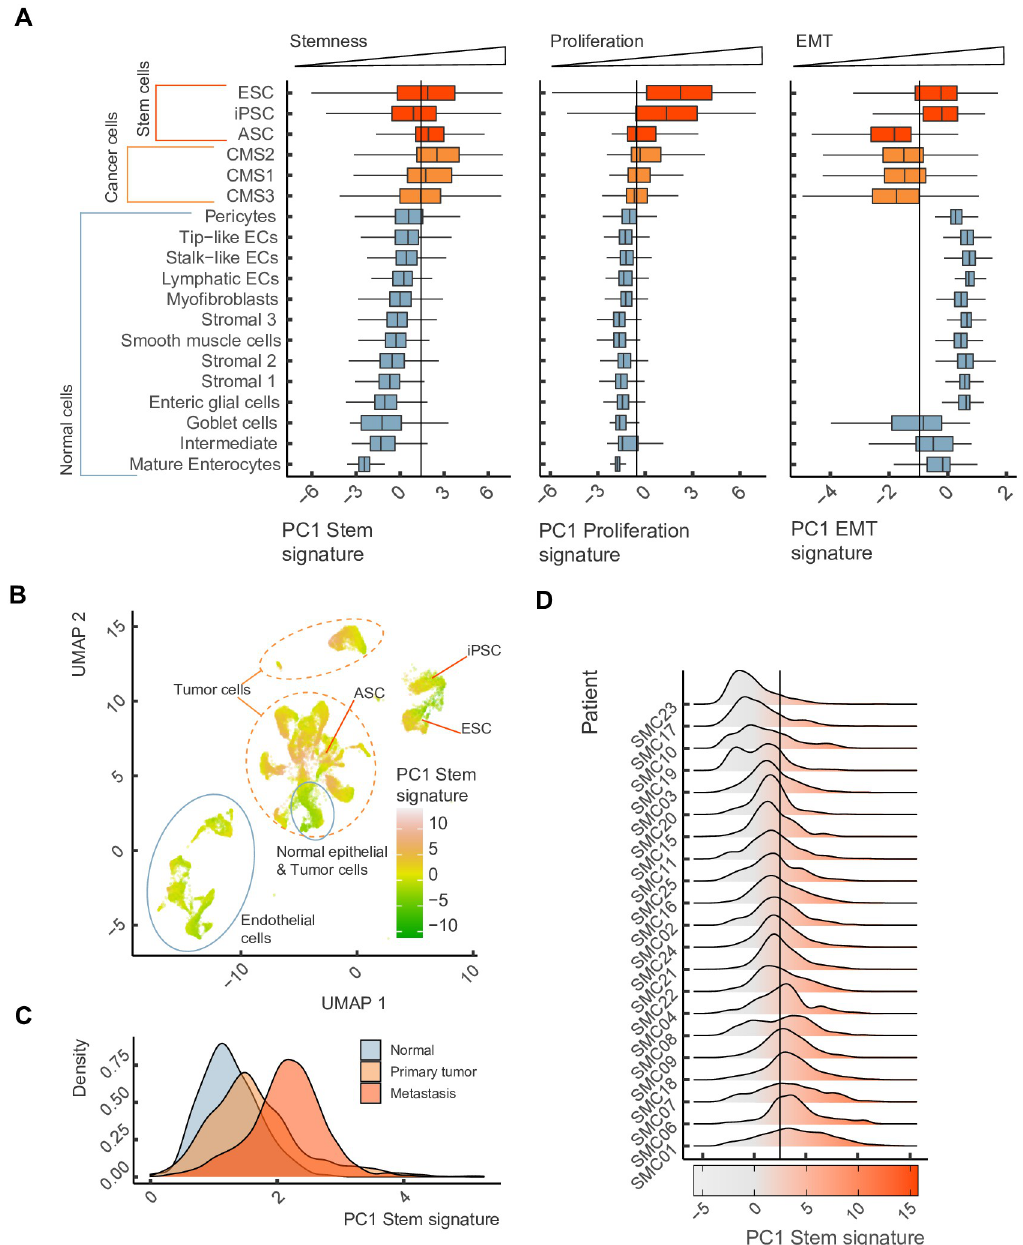
Fig 8. Cancer cells show heterogeneity in stemness, proliferation and EMT scores. (A) Stemness, proliferation and EMT scores in single cells by cell type. Boxplots colors correspond to normal (blue), colorectal cancer (orange), and stem (red) cells. (B) Two dimensional embedding derived from UMAP colored by the stemness score from panel A. (C) Stemness scores computed for single cells from primary lung adenocarcinomas (orange), metastatic lesions (red), and surrounding normal tissues (blue). (D) Stemness scores of colorectal cancer cells from different